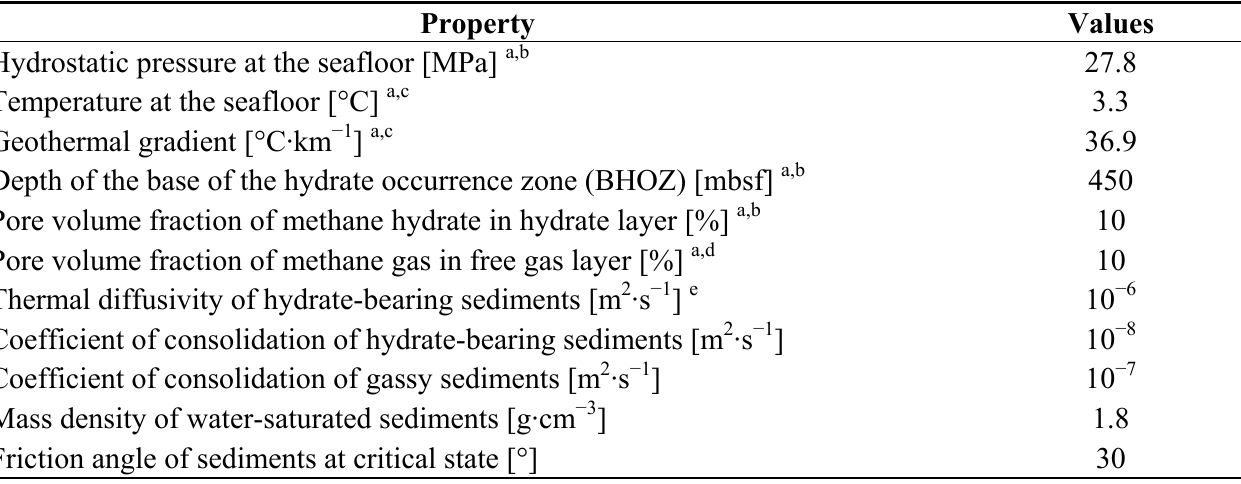
Table 2. Geological conditions and properties of hydrate-bearing sediments used in this